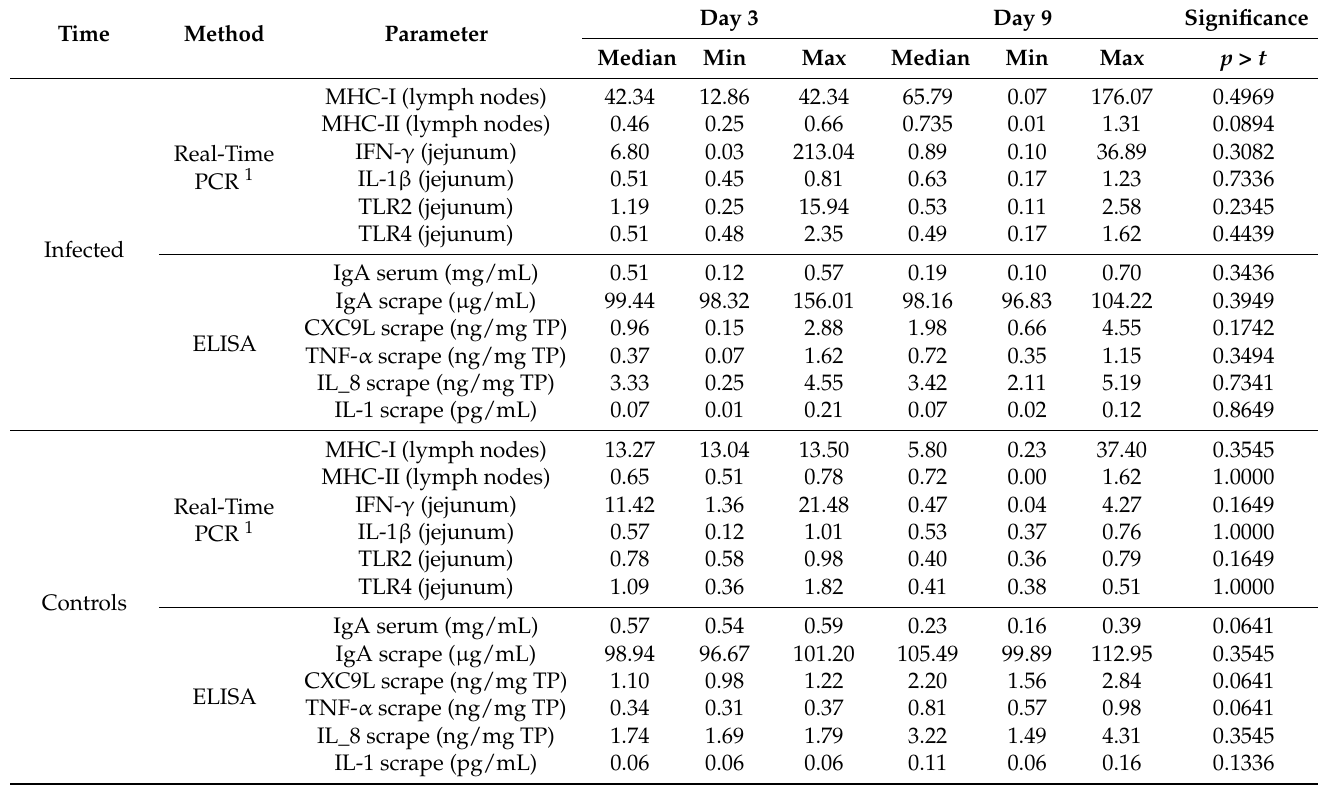
Table 6. Median PCR and ELISA parameters obtained at 3 and 9 days for infected and controls.